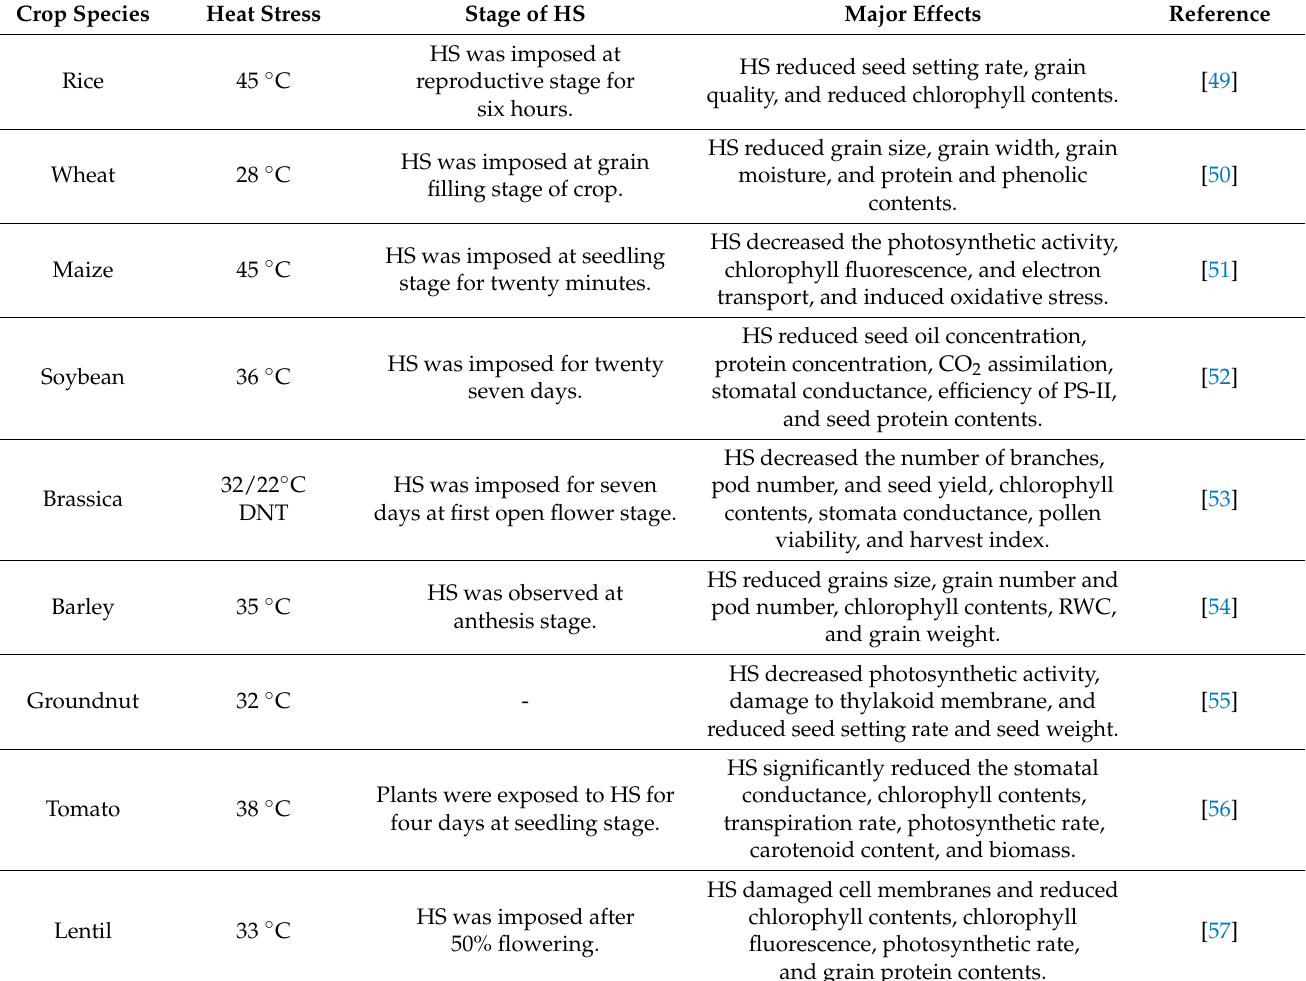
Table 1. Effects of different heat stress levels on the growth, physiology, and yield of different